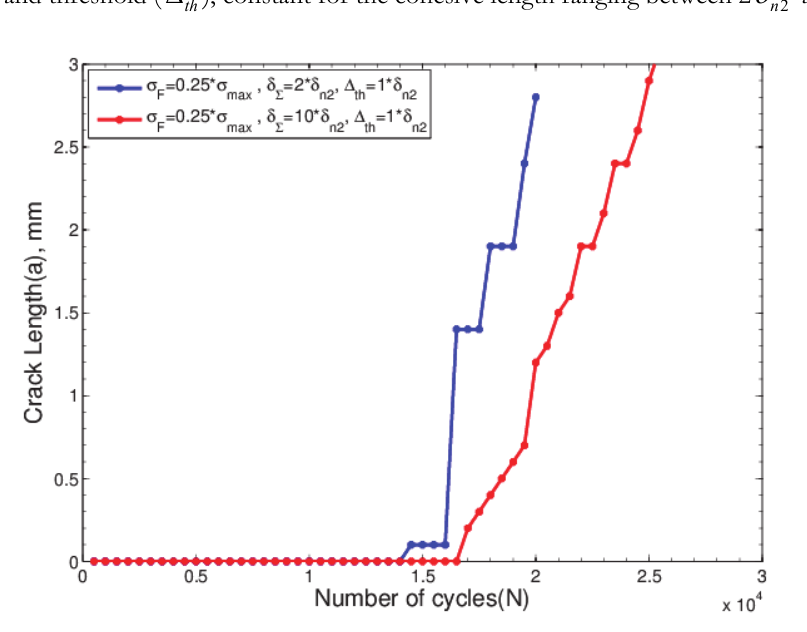
Figure 5: Effect of cohesive length ( δ Σ ) parameter on the fatigue crack growth